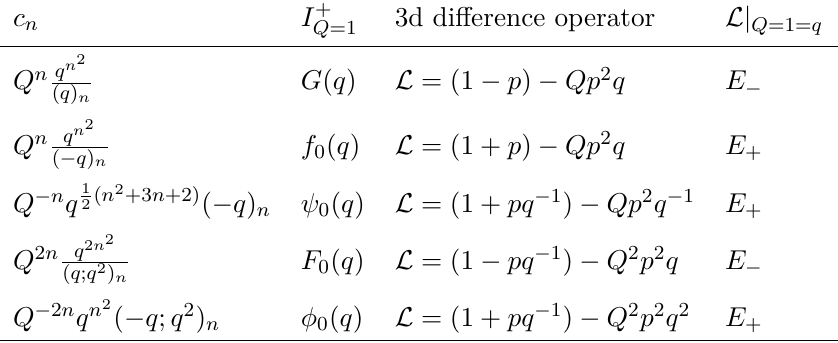
Table 1 . Level k = 2 indices and their modular and mock modular